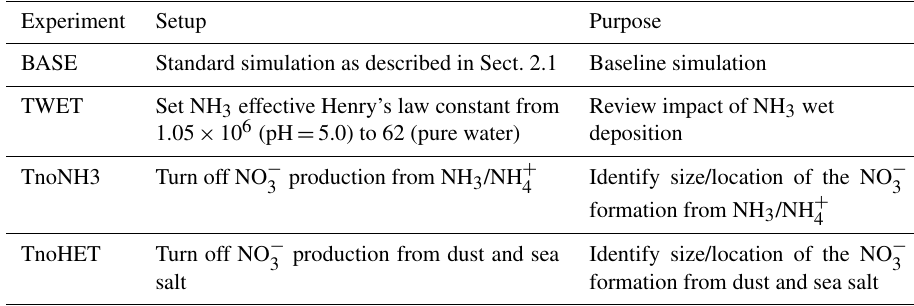
Table 6. Baseline and three sensitivity experiments in the GMI model.